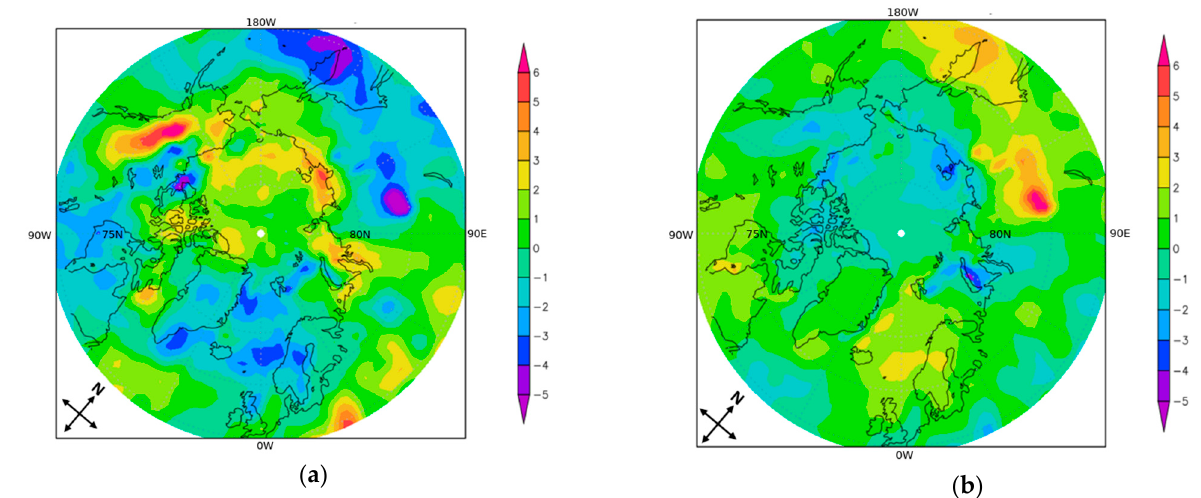
Figure 13. The ensemble averaged anomaly of incoming solar radiation on the surface (with a clear sky) ( a ) and radiative heating of the atmosphere (with a clear sky) ( b ), July, W/m 2 .